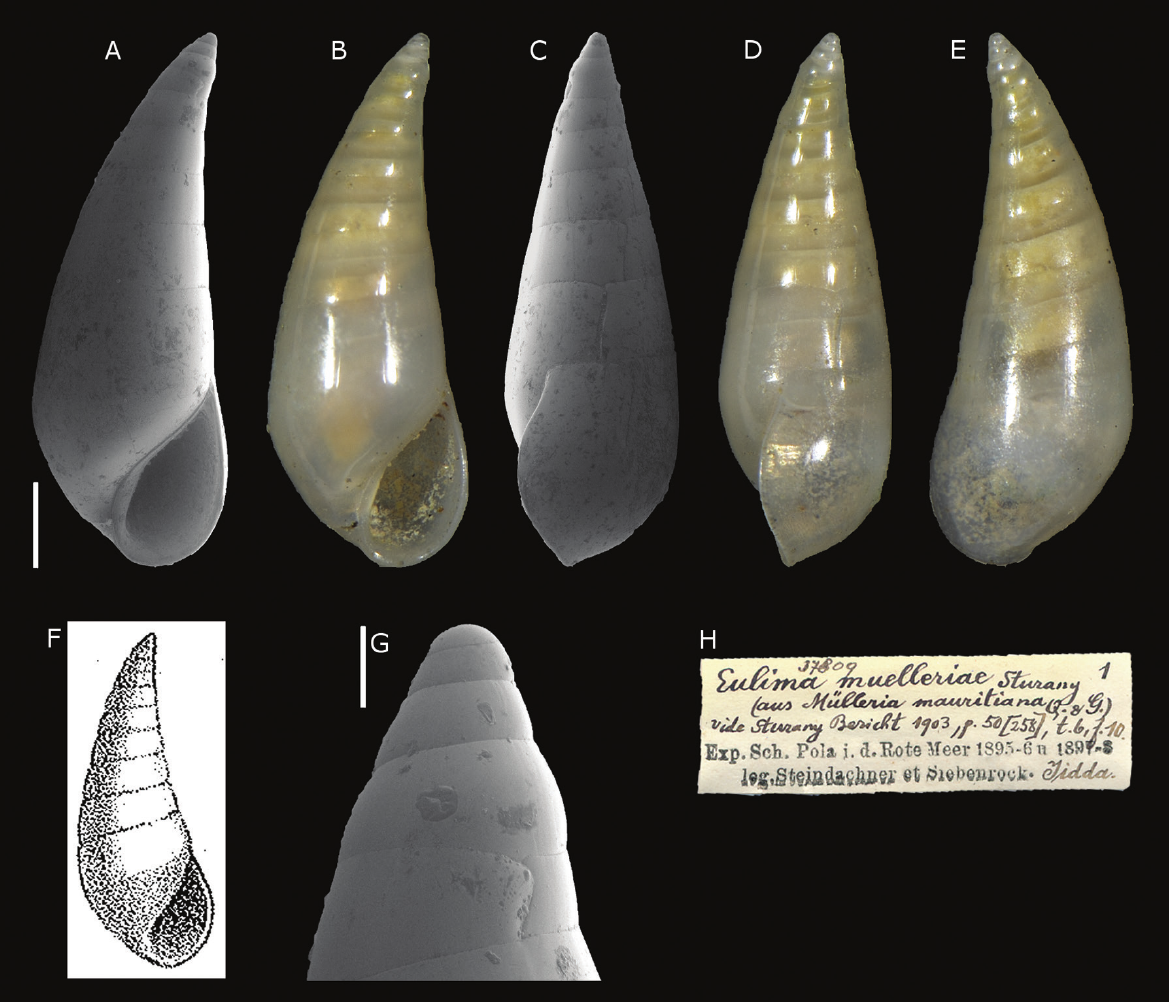
Figure 5 . Eulima muelleriae Sturany, 1903, Locality 31 (Jeddah, Saudi Arabia, Red Sea). A–E , G . Holotype, NHMW 37809: front ( A–B ), right side ( C–D ), back ( E ), protoconch ( G ). F . Original figure by Sturany (1903). H . Original holotype label. Scale bars: A–E : 0.5 mm, G : 0.1 mm.